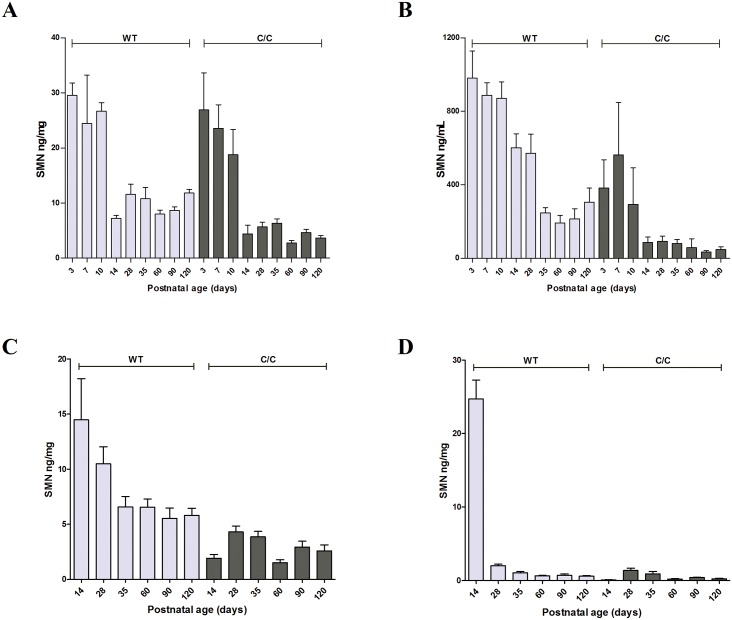
SMN protein levels in WT and C/C-allele SMA mice of different ages.SMN protein levels were measured by SMN-ECL at various days post-birth in (A) brain, (B) whole blood, (C) spinal cord, and (D) gastrocnemius muscle.